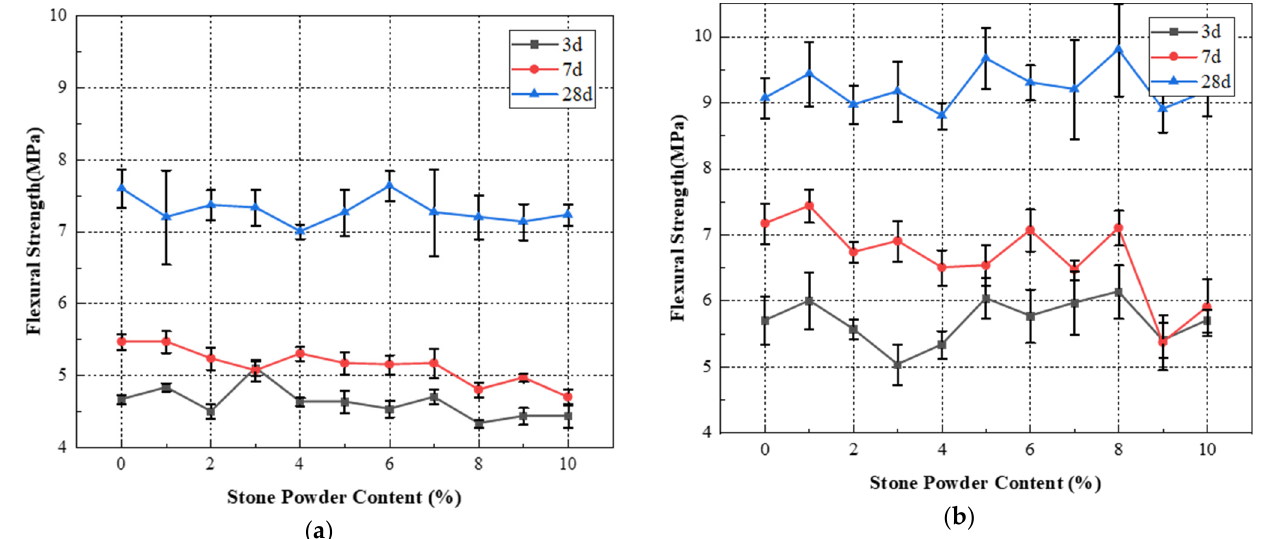
Figure 4. Flexural strength of mortar versus stone powder content curve: ( a ) standard sand; ( b ) machine-made sand.